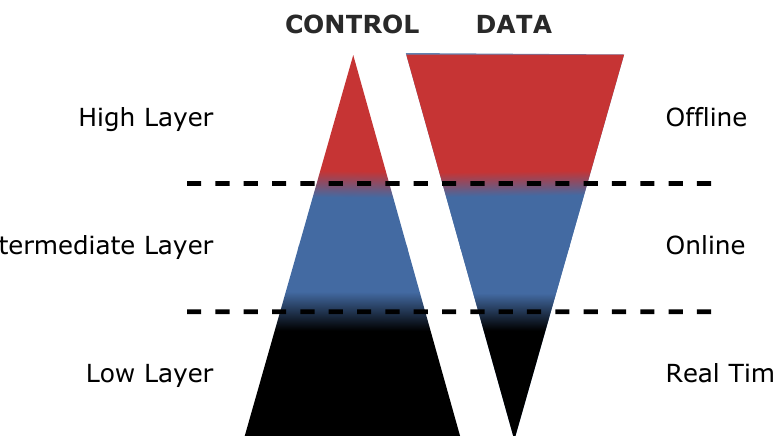
Figure 6. Relationship between data and control for different